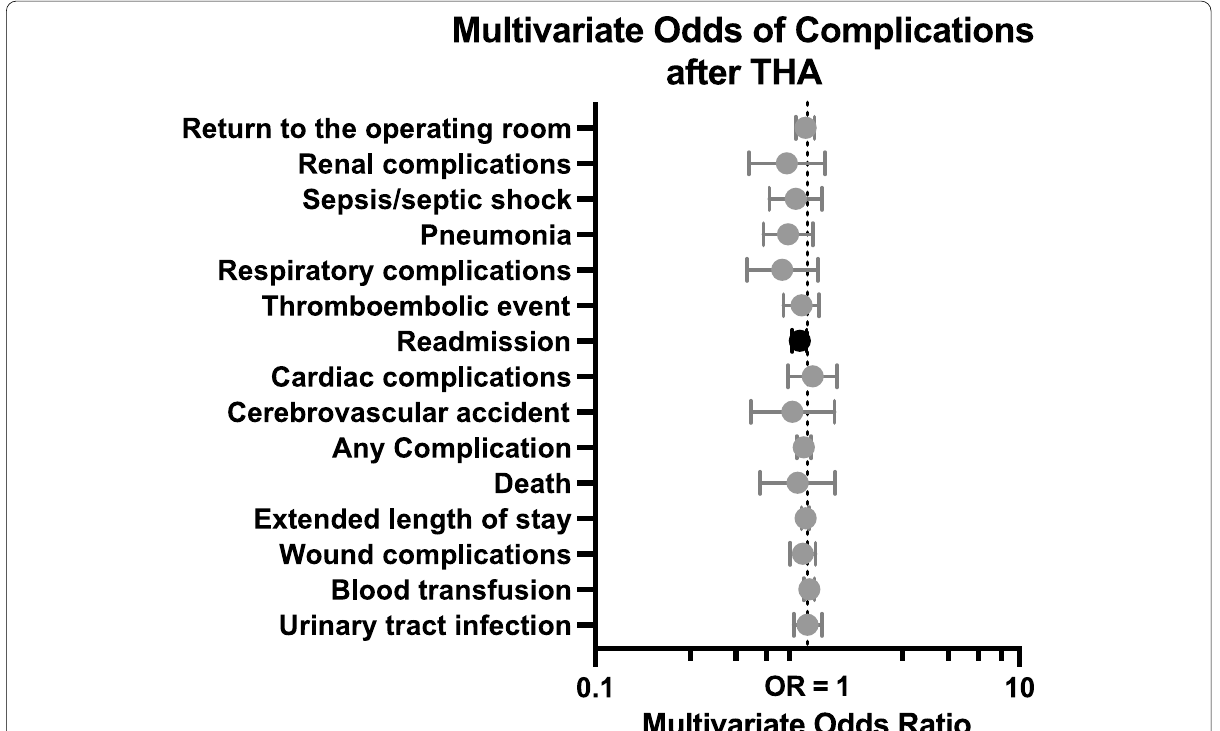
Fig. 2 Relative risk of complications that occurred anytime during the 30-day postoperative period following total hip arthroplasty in non-dehydrated vs . dehydrated patients. Dark shading indicates statistical